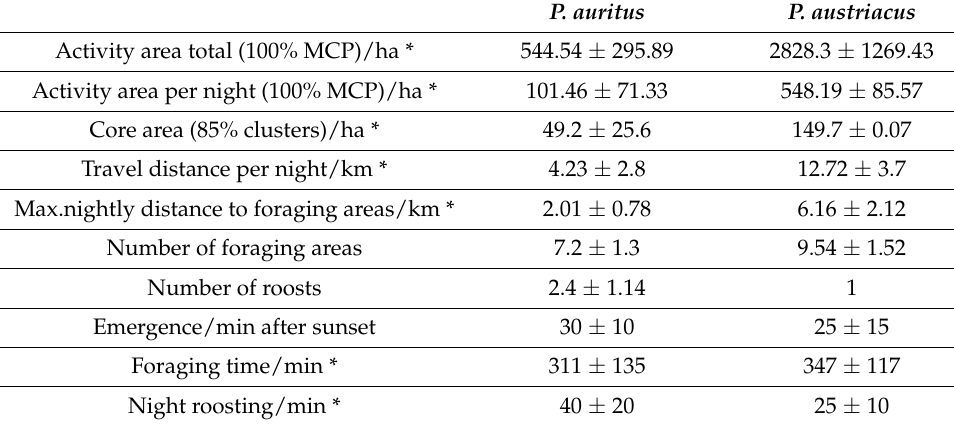
Table 1. Spatio-temporal behavior of female radio-tracked Plecotus auritus ( n = 5) and Plecotus austriacus ( n = 5). Values for each parameter are presented as mean ± SD; 100% MCP areas are given in area total (over full tracking period) and per night; core areas = total area of all 85% cluster cores over the radio-tracking period; * significant differences ( p ≤